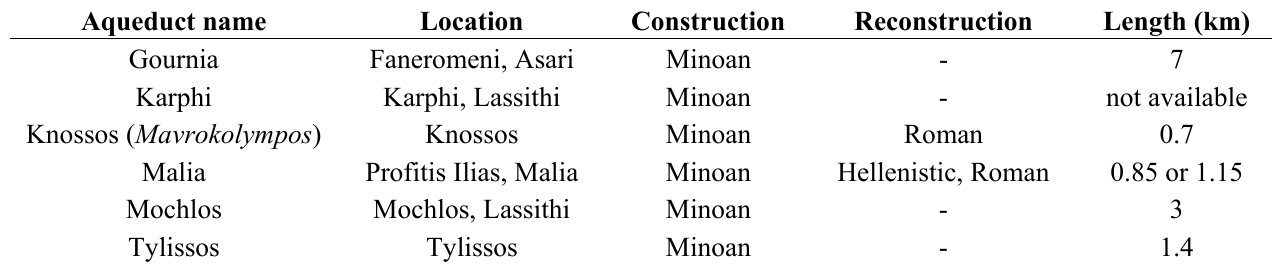
Table 2. Characteristics of major aqueducts in Minoan Crete (adapted from Angelakis and Spyridakis